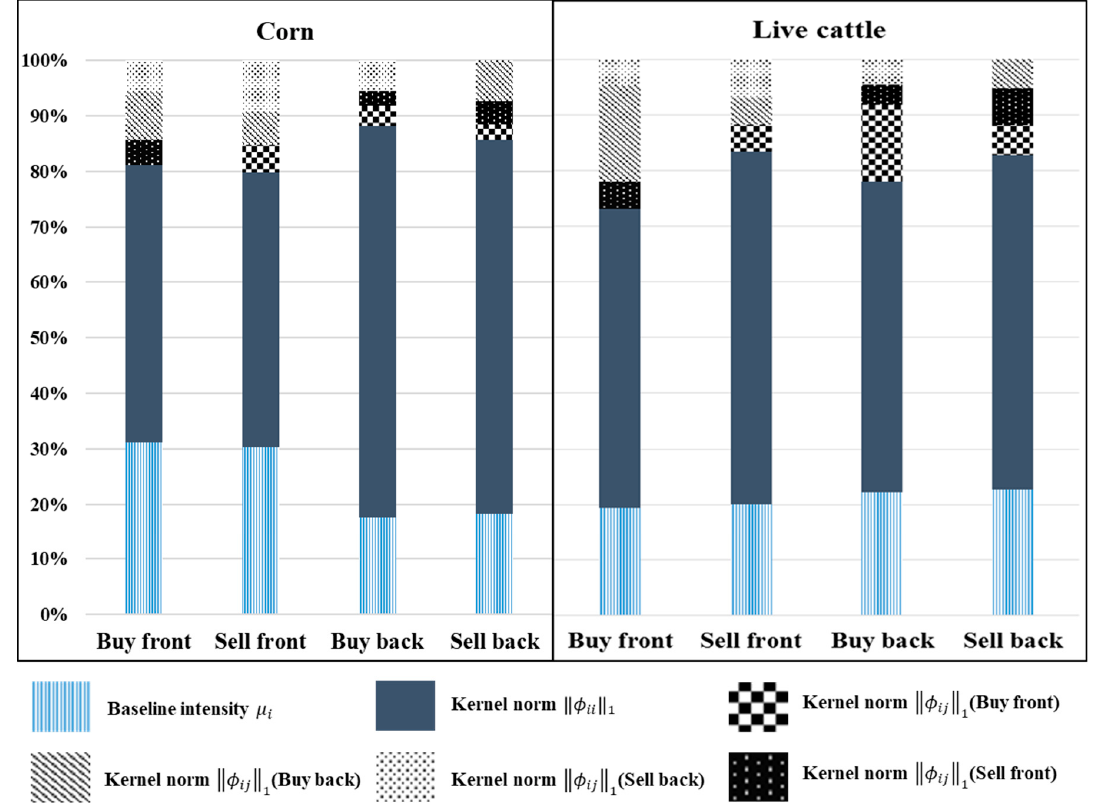
Figure 5. Composition of the estimated intensity for corn and live cattle.